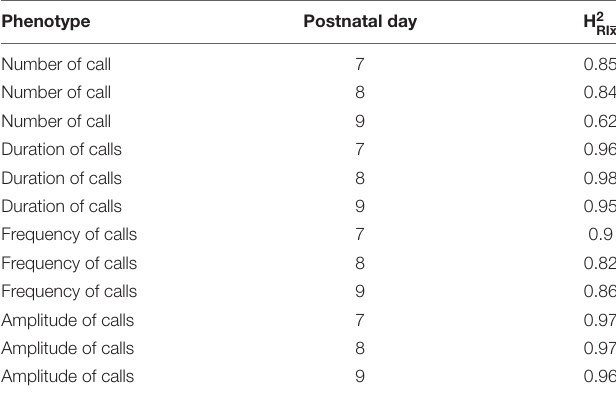
TABLE 1 | H 2 RIx estimates (heritability accounting for repeated sampling of the same genome) for quantitative traits in the B6/D2 diallel cross, measured on postnatal days 7, 8, and 9.